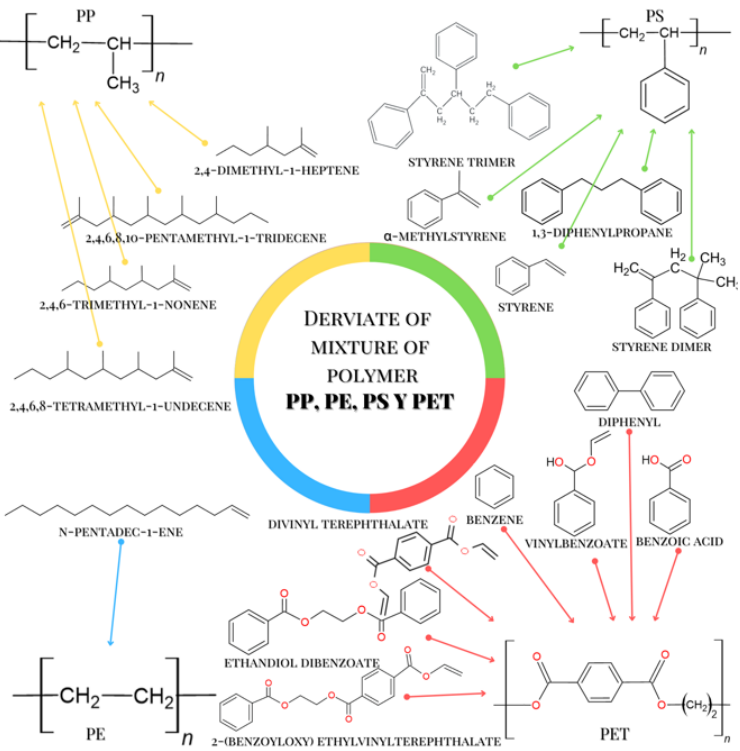
Figure 6. Chemical compounds identified by GC-MS and MPs that originate it.